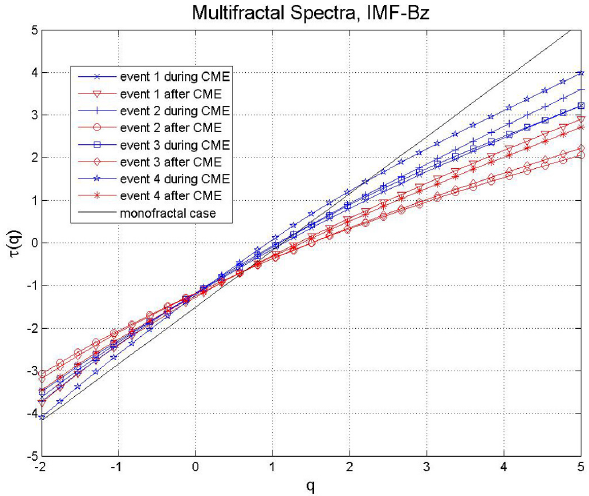
Fig. 3. Multifractal spectral from time series during CME events, after CME events and monofractal case (straight black line). The legends indicate every event studied.